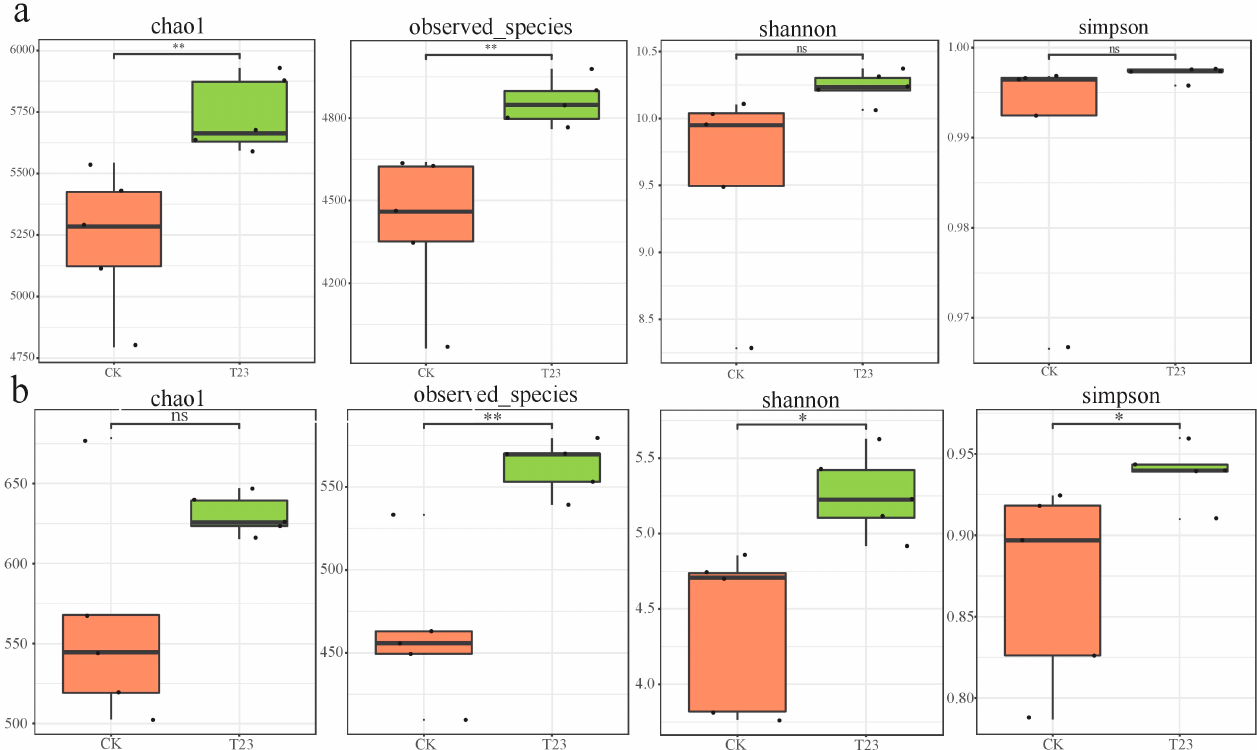
Figure 1. Effects of T. viride T23 on the microbial diversity of muskmelon rhizosphere soil. ( a ) Diversity index of the bacterial community. ( b ) Diversity index of the fungal community. * indicates that the two groups of data have significant differences, ** indicates that the two groups of data have extremely significant differences, and ns indicates that there are no significant differences.